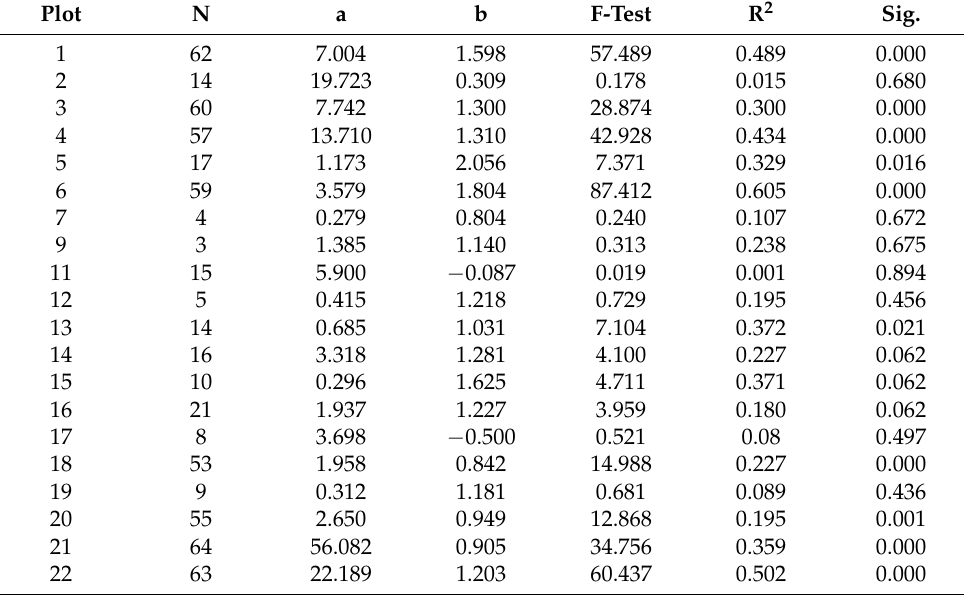
Table 5. Relationships between event runoff depth (H) and soil loss rate (SLR) (SLR = aH b ) for the 22 runoff